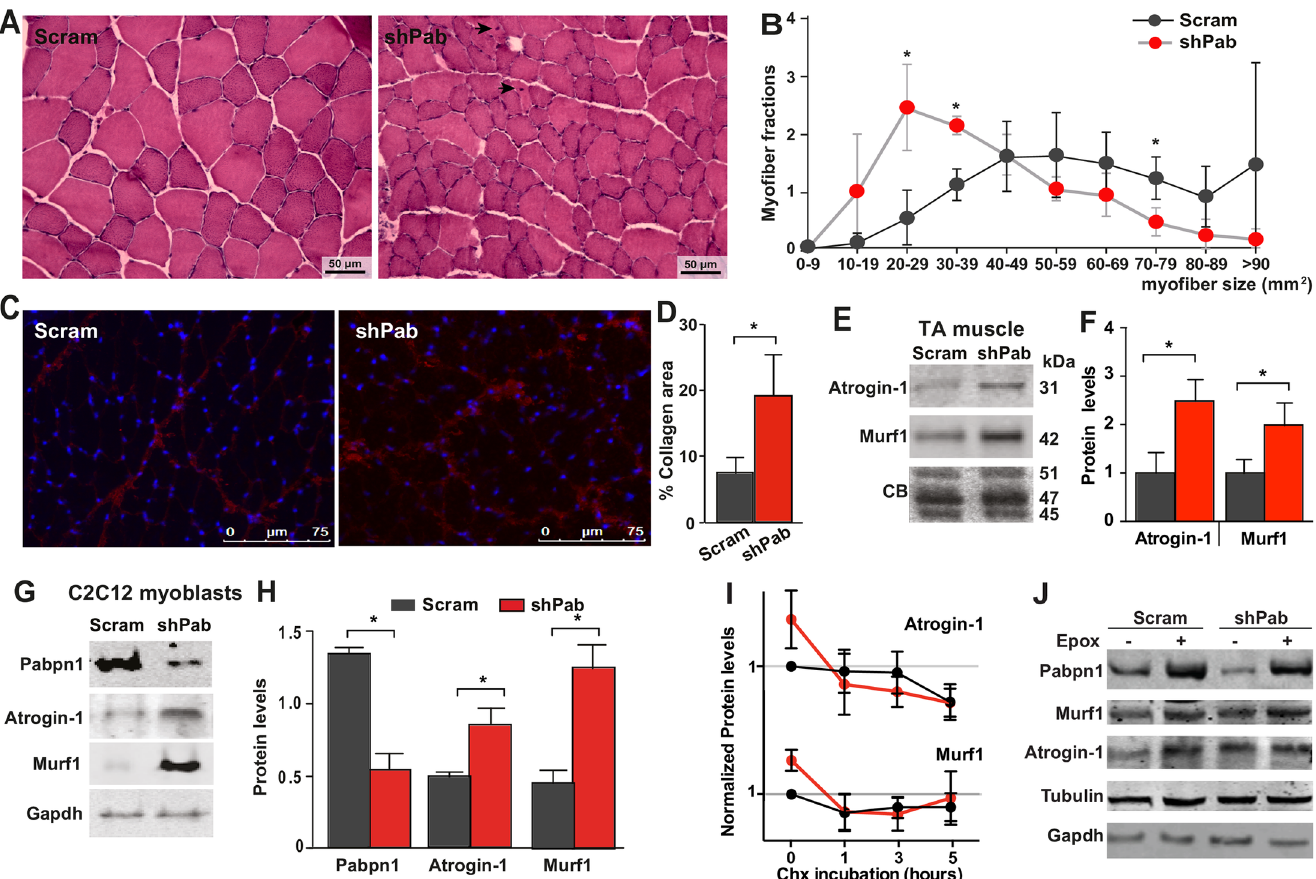
Fig 4. Histopathological characteristics of Pabpn1-DR muscles. A-B. Haematoxylin and eosin staining of muscle tissue. Myofibers with central nucleation are indicated with black arrows. Scale bar is 50 μ m. B. Quantification of myofiber cross-sectional area. C-D. Quantitation of thickening of ECM in Pabpn1-DR muscles. (C) Shown are representative images of muscle sections stained for Collagen 1 and counterstained with DAPI. Scale bar is 75 μ m. (D) Percentage of collagen positive area of muscle sections. Bars show SD from three mice. E-F. Western blot (E) shows Atrogin-1 and Murf1 protein levels in Scram and shPab muscles. Bar charts (F) show means of Atrogin-1 and Murf1 levels normalized to the average of three proteins (45, 47 and 51 kDa). Averages and SD are from three mice. G-H. Atrogin1 and Murf1 protein levels in Scram and shPab cell cultures. Gapdh is used as loading control. Averages and SD are from three biological replicates. Statistical significance was assessed by paired student ’ s t-test. P-value < 0.05 was considered statistically significant and indicated by an asterisk. I. Dot plots show protein accumulation of Atrogin-1, Murf1 in Scram (in black) or shPab (in red) cell cultures after Chx treatment for 0, 1, 3, 5 hours. Protein levels were normalized to untreated in Scram cultures (time 0). Averages and standard deviations are from three independent experiments. Equal loading was assessed by Tubulin and Gapdh (representative blots are shown in S5 Fig). J. Western blot shows protein accumulation in mock or Epox treated myoblasts cultures. Blots were incubated with antibodies to Pabpn1, Murf1, Atrogin-1, or Gapdh and Tubulin as loading controls.